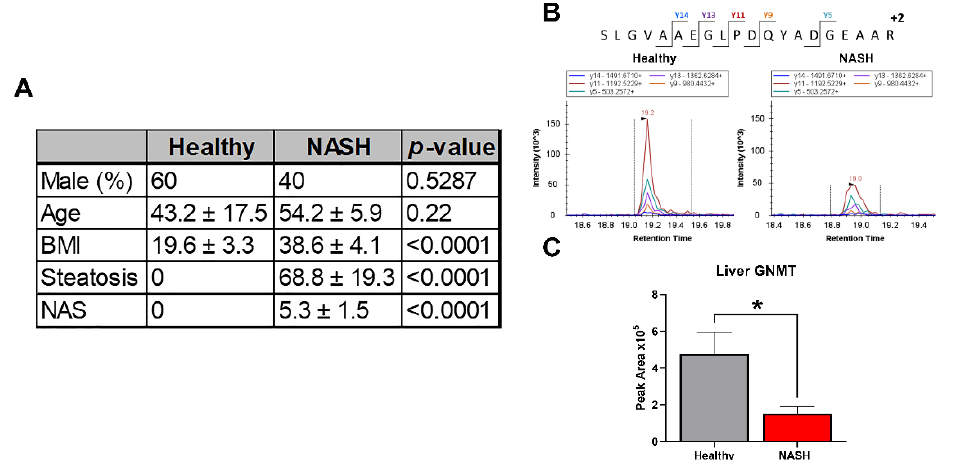
Figure 1. GNMT is downregulated in human NASH liver. ( A ) Table displaying patient characteristics for healthy and NASH liver samples. ( B ) Representative chromatograms from selected reaction monitoring analysis. ( C ) GNMT protein abundance in human liver samples. Data presented as mean ± SEM (N = 5, * p < 0.05).